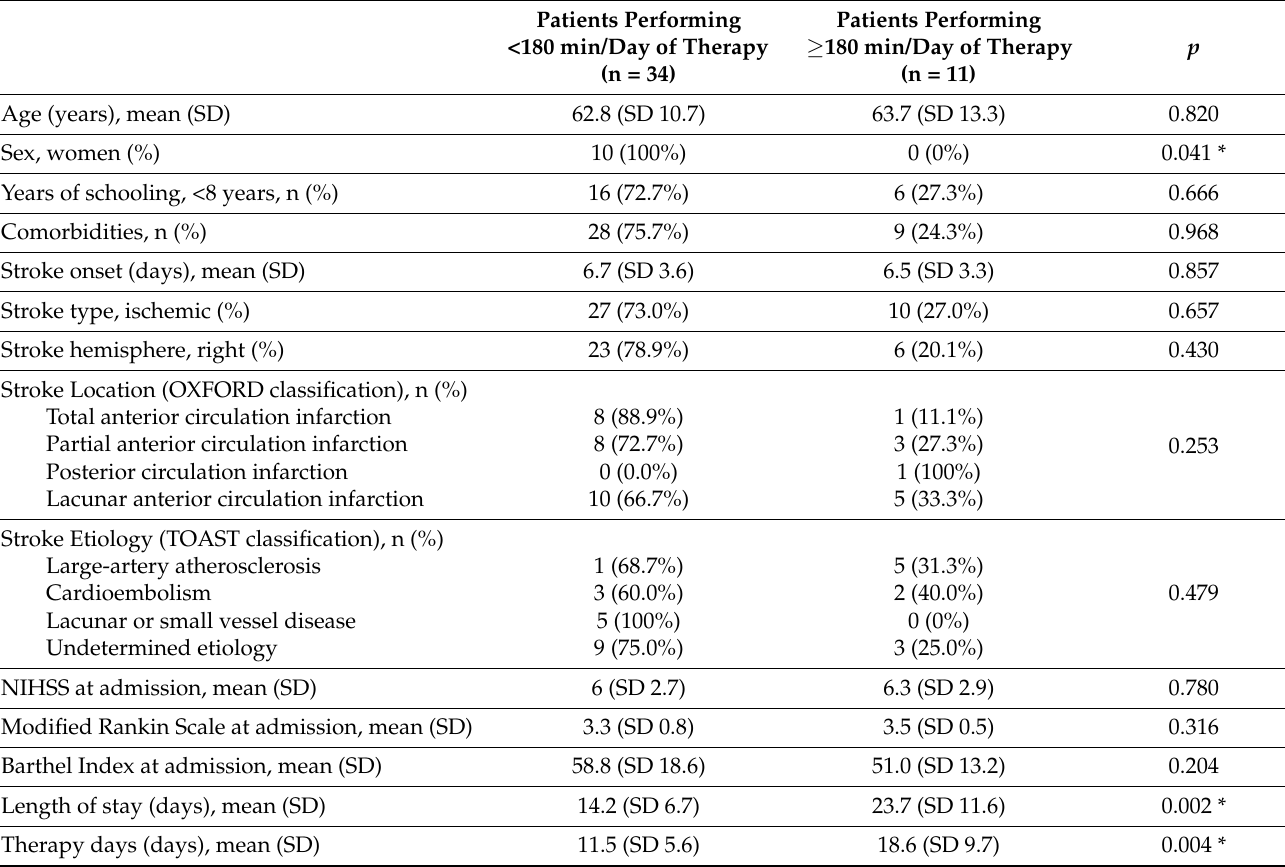
Table 4. Characteristics of patients according to the achieved goal of performing at least 180 min of daily rehabilitation